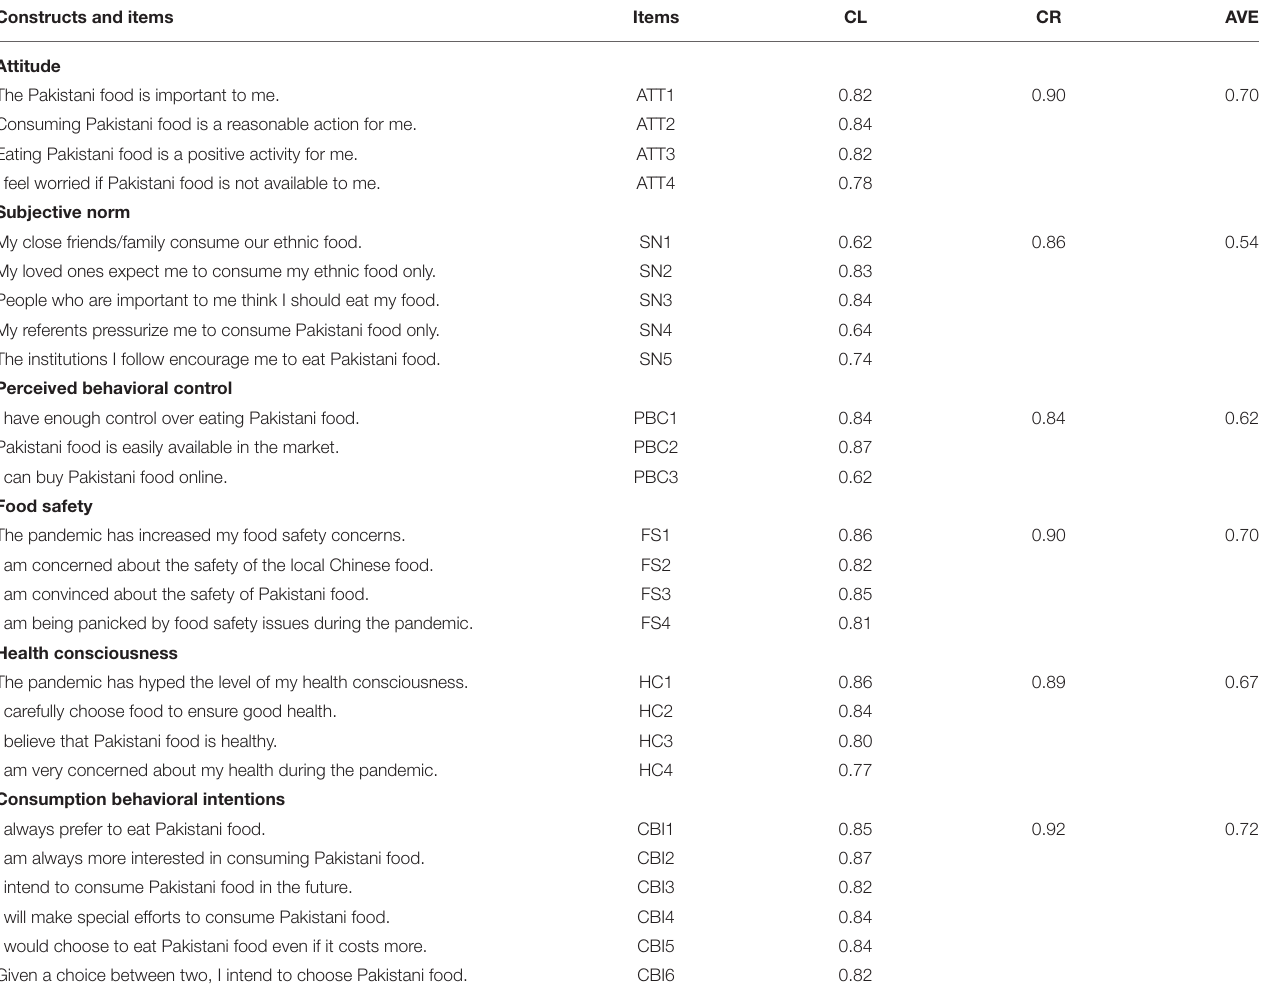
TABLE 2 | Convergent validity assessment ( n = 462). Constructs and